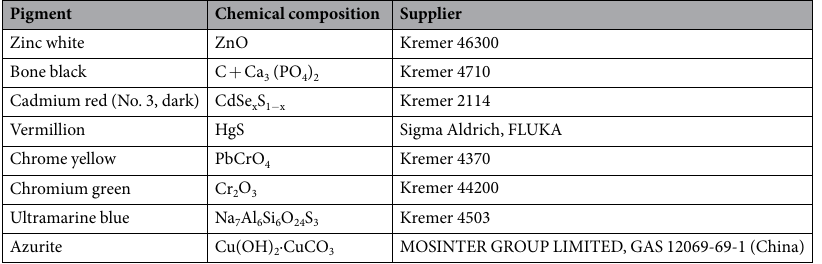
Table 1. Pigments used for the preparation of paint